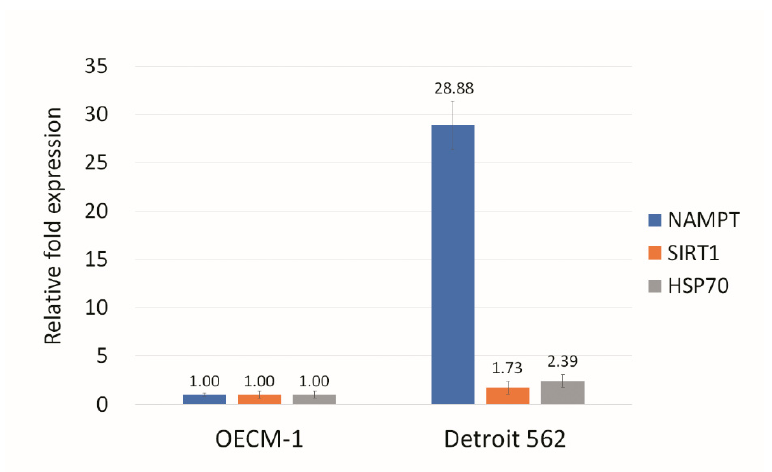
Figure 6. NAMPT has a higher level of expression in Detroit 562 cells than in OECM-1 cells. Although the levels of NAMPT, SIRT1, and HSP70 expression in Detroit 562 were larger than in OECM-1, the NAMPT expression showed, by far, the greatest difference between the two cell lines. Gene expression in OECM1 cells was calculated as 1.